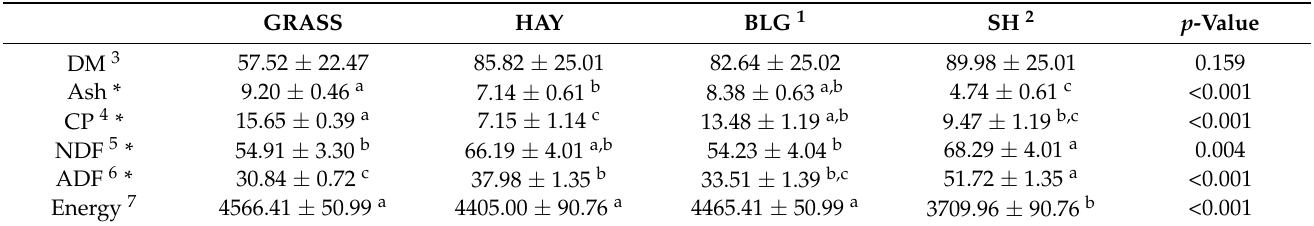
Table 1. Mean proximate composition of the feeds.